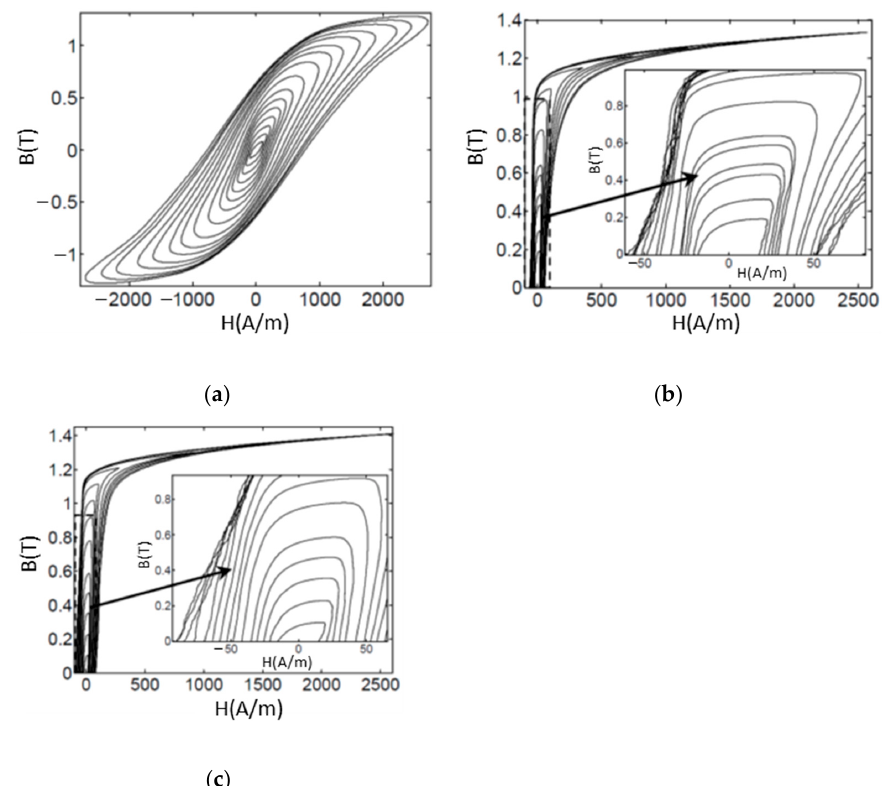
Figure 13. Dynamic hysteresis loops at 50 Hz, samples FeSi6.5, ( a ) sample with full-section; ( b ) sample with optimized Section 1; ( c ) sample with optimized Section 2.